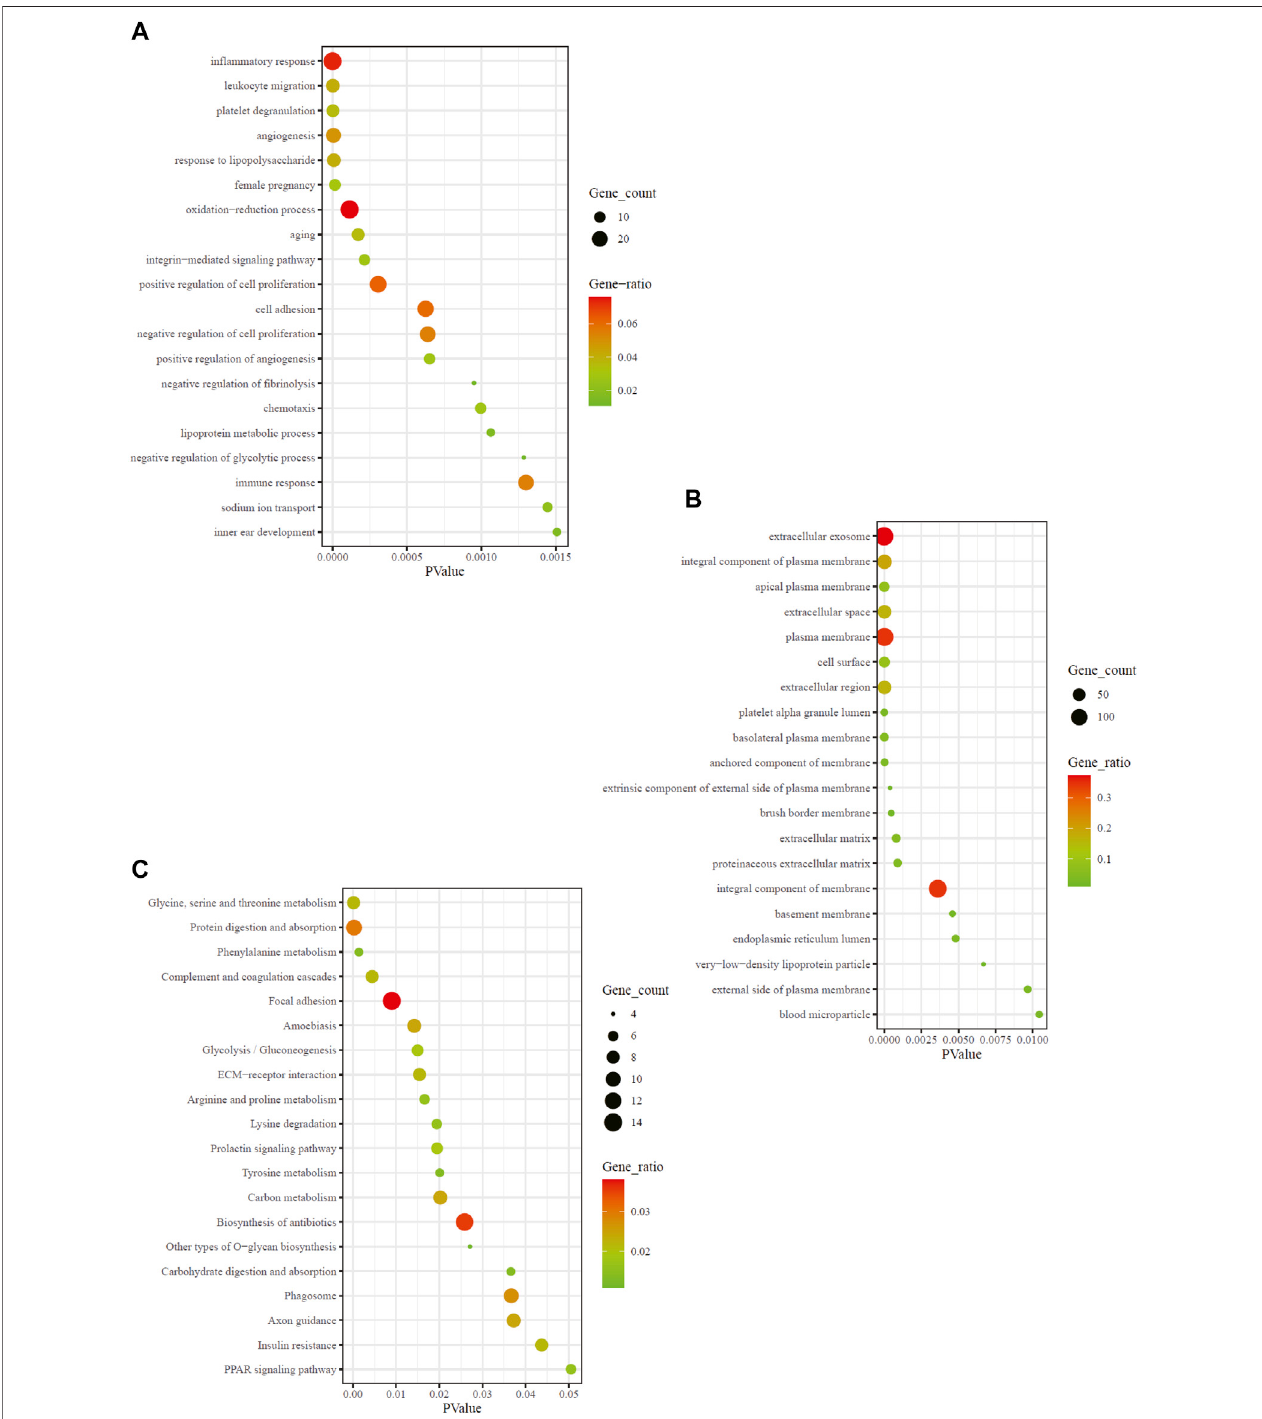
FIGURE 2 | GO and KEGG enrichment result of DEGs. The x -axis represents p value and y -axis represents GO terms. The size of circle represents gene count. Differentcolorofcirclesrepresentsgeneratio. (A) GO-BPenrichmentresultofDEGs. (B) GO-CCenrichmentresultofDEGs. (C) KEGGenrichmentresultofDEGs.DEG: differentially expressed gene; KEGG: Kyoto Encyclopedia of Genes and Genomes; GO: Gene Ontology; BP: biological process; CC: cell composition.